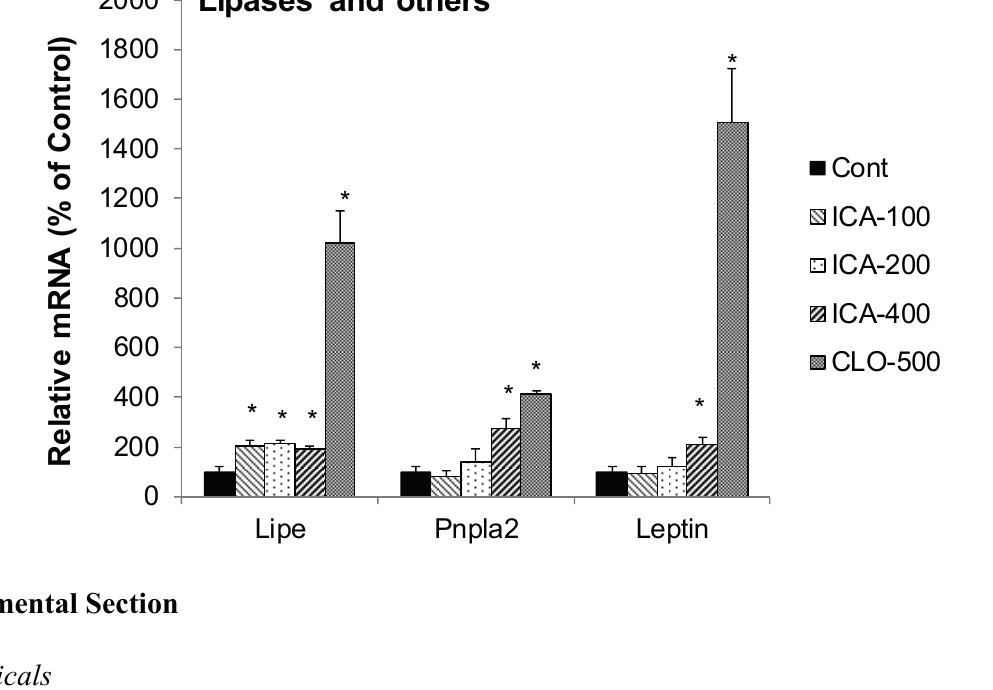
Figure 6. Effects of Icariin (ICA) on expression of lipolytic enzymes. Data are expressed as mean ± SEM (n = 5). * Significantly different from CMC-treated mice ( p <